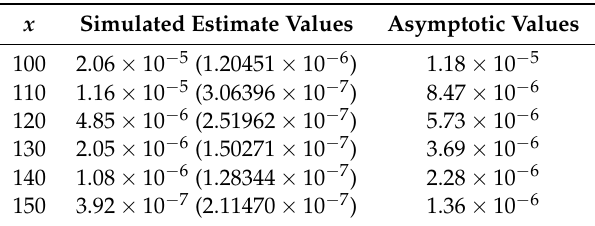
Table 1. Comparison between the simulated estimate values and the asymptotic values in Theorems 1-(2) for N = 1.0 × 10 7